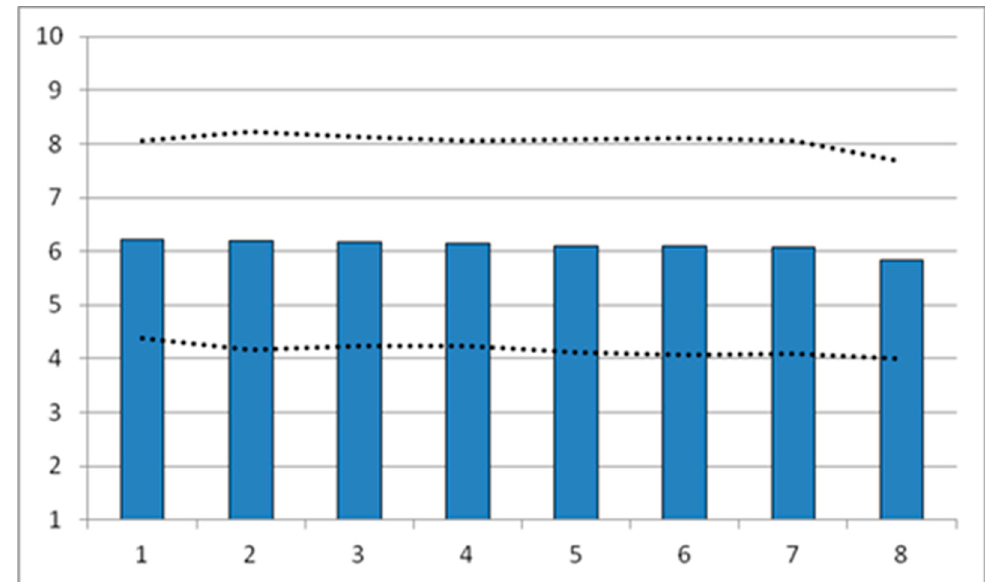
Figure 2. Graphic image of arithmetic means X ± S of individual factors, based on the opinions of service recipients. Figure Legend: 1. Preparation of infrastructure for residents; 2. Promoting the idea of an active lifestyle; 3. Creating the city’s image through sports and recreation; 4. Expansion of infrastructure; 5. Poznan as an international sports center; 6. Supporting mass sport; 7. Promoting sports for children and teenagers; 8. Operation of sports clubs.